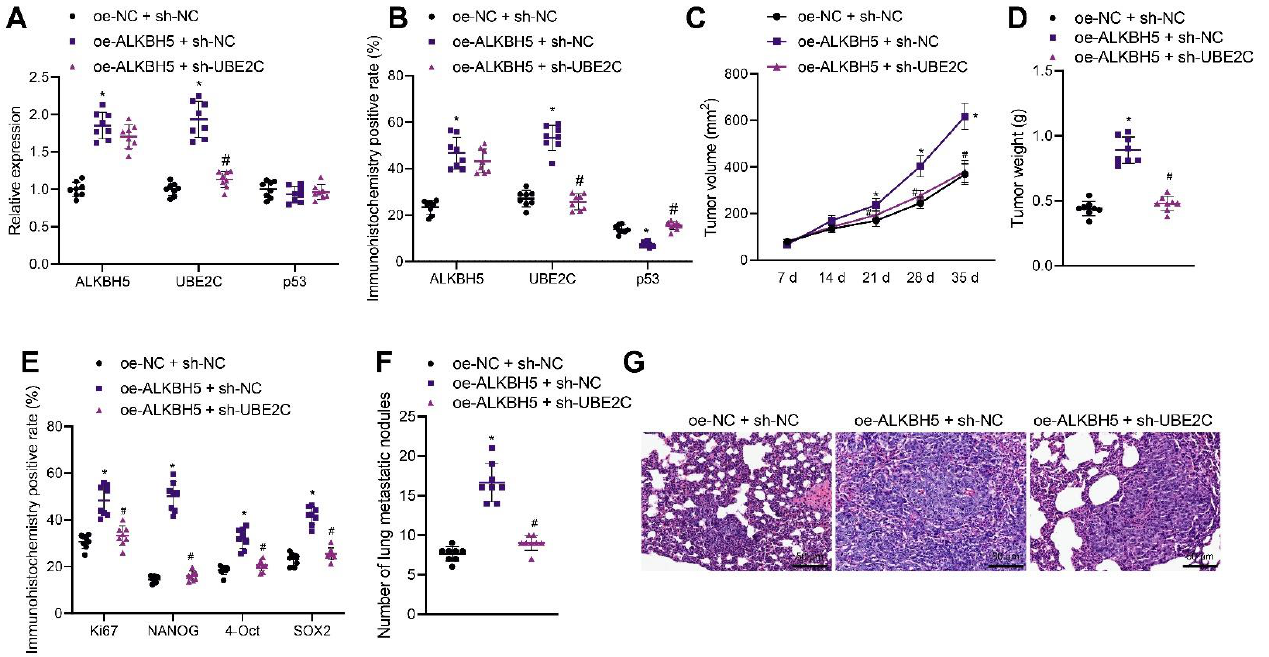
Figure 6. ALKBH5 accelerates TNBC cell growth and metastasis via the UBE2C/p53 axis in vivo. Mice were treated with oe-ALKBH5 along or in combination with sh-UBE2C. ( A ): mRNA expression of ALKBH5, UBE2C and p53 in the tumor tissues of mice determined by qRT-PCR; ( B ): Positive expression of ALKBH5, UBE2C, and p53 proteins in the tumor tissues of mice determined by immunohistochemistry; ( C ): Tumor volume of mice; ( D ): Tumor weight of mice; ( E ): Positive expression of Ki67, NANOG, OCT4, and SOX2 proteins in the tumor tissues of mice determined by immunohistochemistry; ( F ): Statistics of number of lung metastatic nodules in mice; ( G ): Lung metastasis of breast cancer cells analyzed by HE staining. n = 8. * p < 0.05, compared with the mice treated with oe-NC + sh-NC and # p < 0.05, compared to the mice treated with oe-ALKBH5 + sh-NC. Measurement data are expressed as mean ± standard deviation and comparisons between multiple groups were conducted by one-way ANOVA or repeated measures ANOVA. Oe-: overexpress; sh-: RNA-Short hairpin RNAs.